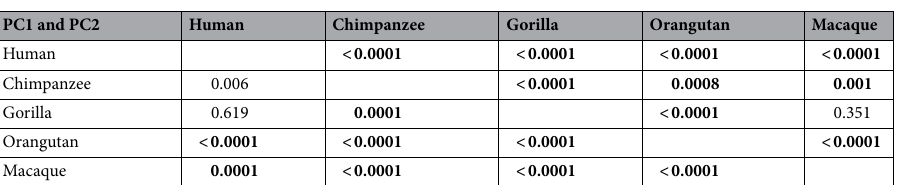
Table 2. P -value of post-hoc tests for multiple comparisons in whole-sample analysis for PC1 and PC2. The right-upper cells represent the P -value for PC1, and the left-lower cells represent PC2. P -values < 0.05 are in bold for PC1, and P -values < 0.005 (0.05/10) are in bold for PC2 to indicate significant